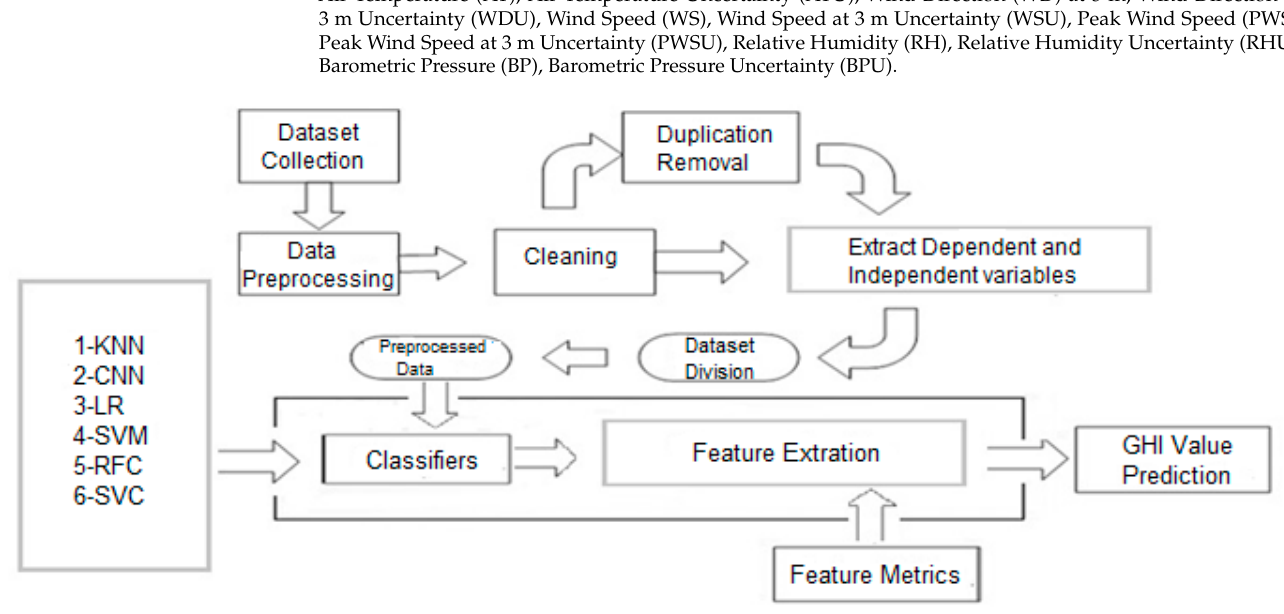
Figure 3. Research workflow to predict GHI Values. Table 1. Dataset description.